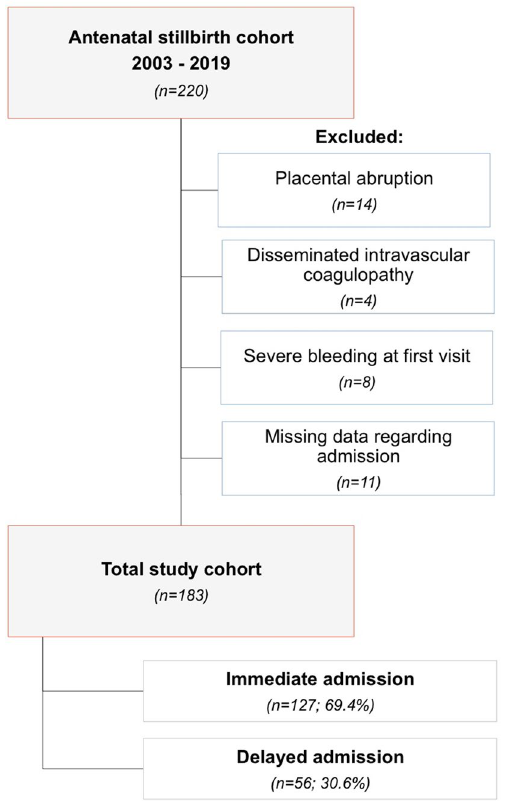
Figure 1. Flowchart on the selection of the study population following fetal death at the Department of Obstetrics and Gynecology, Medical University of Vienna, Austria, between 2003 and